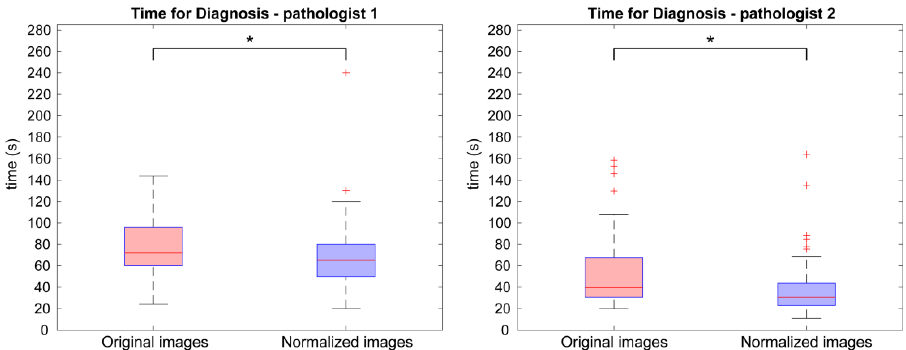
Figure 7. Comparison between time for diagnosis of the original and normalized WSIs. Boxplot of diagnosis time values of original (red) and normalized images (blue) according to the evaluations of the first pathologist (P1) on the left and second one (P2) on the right. The plus symbol (+) indicates outliers in the distribution, while the asterisk (*) denotes a statistically significant difference between original and normalized images.